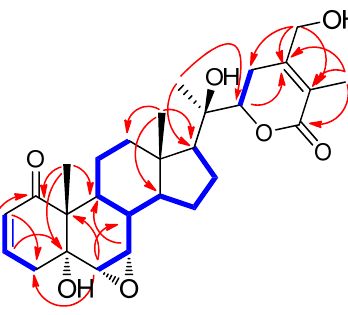
) and heteronuclear multiple bond correlation (HMBC) (